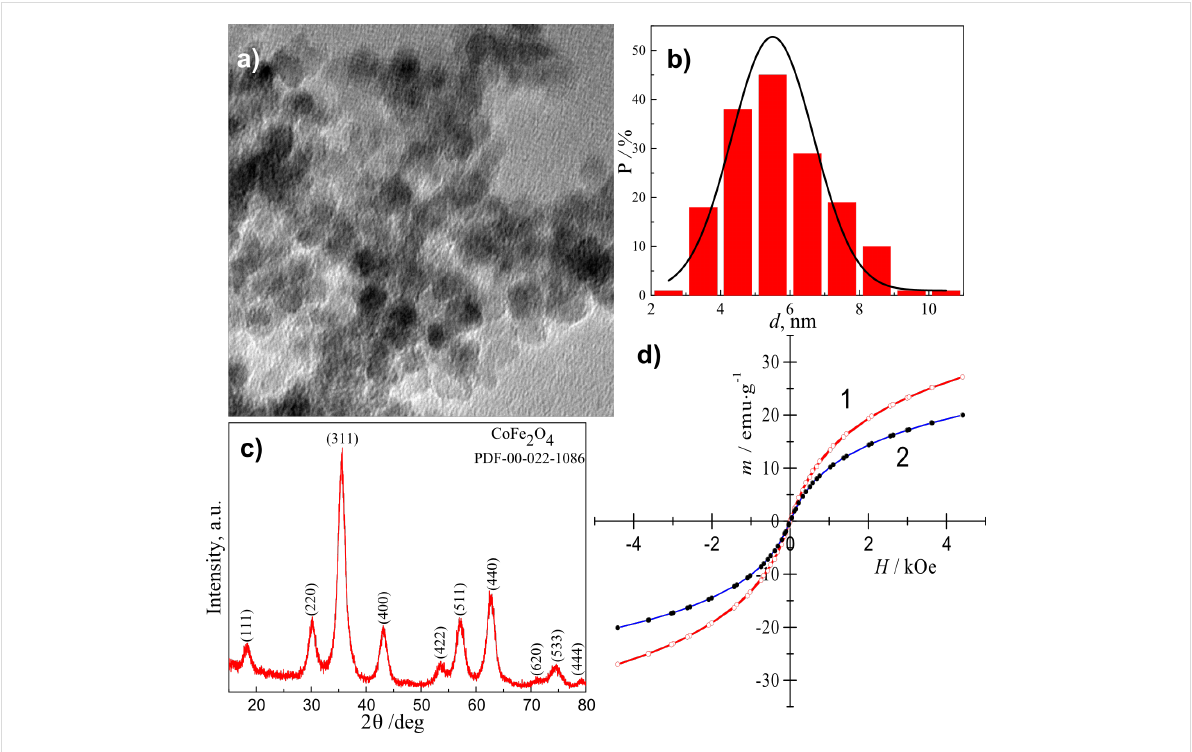
Figure 1: a) TEM image of cobalt ferrite NPs synthesized hydrothermally in a solution containing 25.0 mmol·L − 1 CoCl 2 , 50 mmol·L − 1 FeCl 3 , 0.2 mol·L − 1 methionine, and NaOH to pH 12.4 at 130 °C for 10 h. The size distribution histogram and XRD pattern of the as-formed NPs are shown in panels b) and c), respectively. In panel d) the magnetic responses of as-formed (1) and sonicated NPs in a 10 mmol·L − 1 HAuCl 4 solution, kept at a pH 12.2, at 37 °C for 4 h (2) are presented.